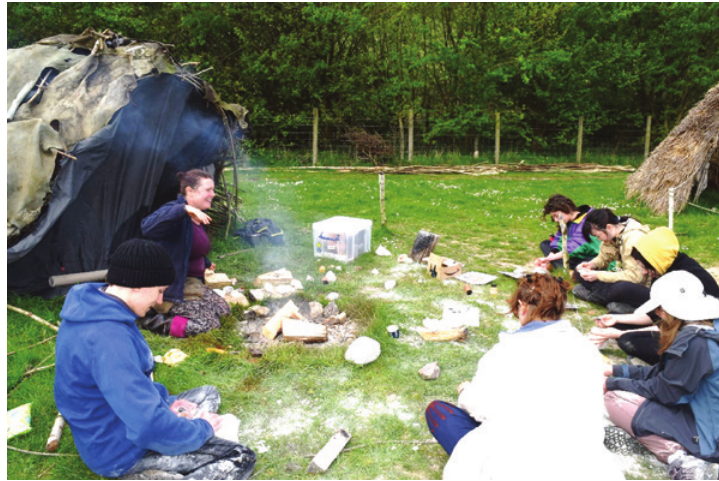
Figure 8 Letty Ingrey (ASE) leading a Palaeolithic art workshop at the spring 2022 event (Source: photograph by Institute of